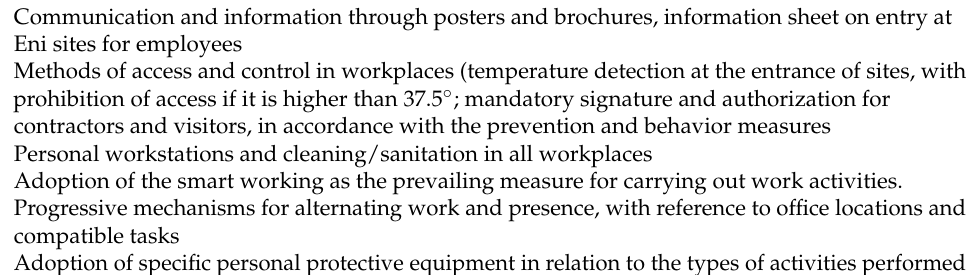
Table 3. Prevention and management measures adopted by the Eni group to fight the pandemic in the